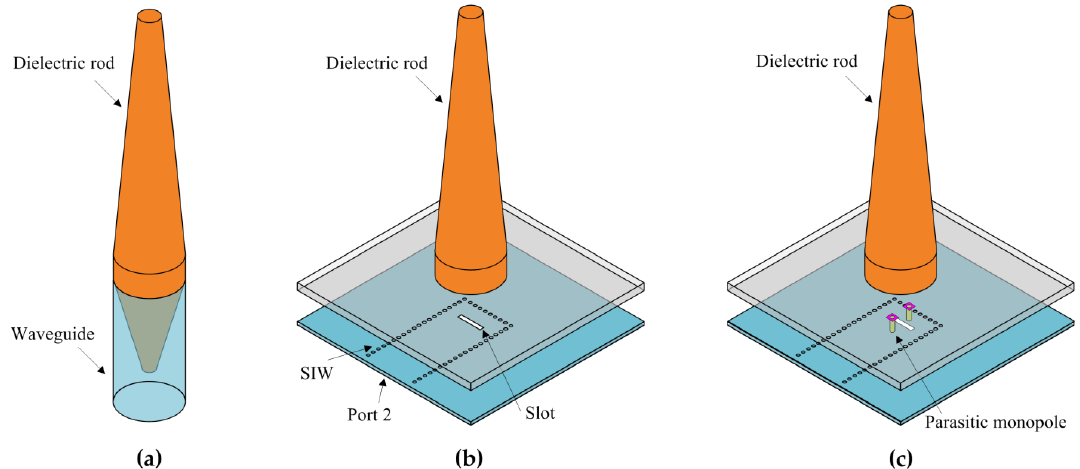
Figure 3. Design evolution of the feeding network for dielectric rod antenna: ( a ) Using a conventional 3-D waveguide feed; ( b ) Using a planar SIW feed; ( c ) Using a planar SIW feed with a pair of parasitic monopoles.